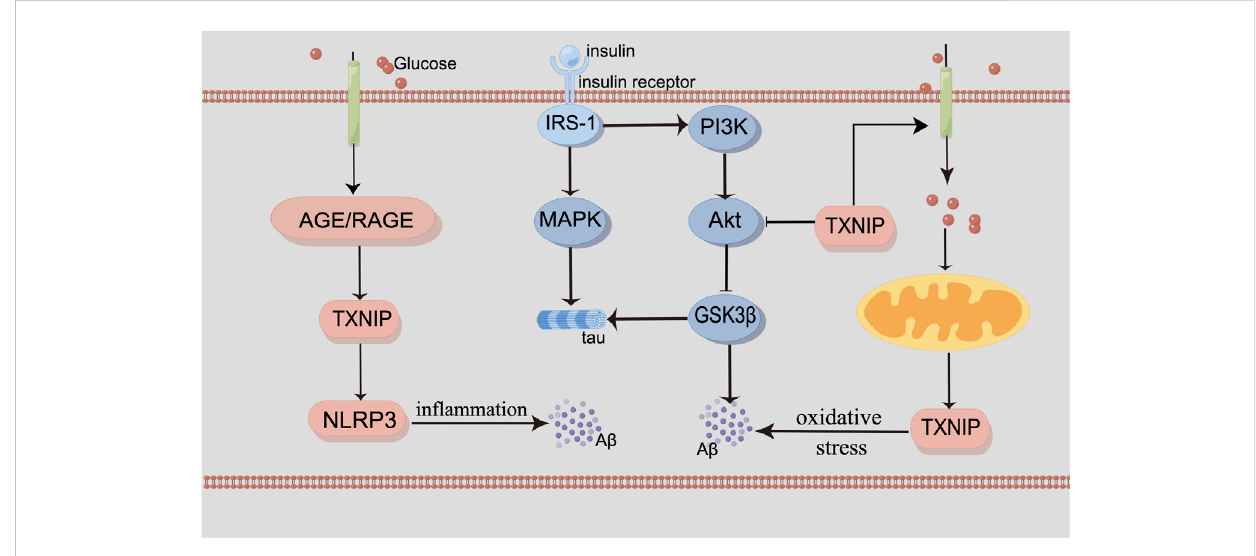
FIGURE 1 ByFigdraw.TheinteractionofglucosemetabolismandthepathogenesisofAD.Insulinbindstotheinsulinreceptor,recruitingtheIRS-1proteinsand triggering two signaling cascades, including the MAPK pathway and the PI3K/Akt/GSK3 β pathway. Inhibition of PI3K and downregulation of the phosphorylated Akt protein subsequently activate GSK3 β . TXNIP is a modulator of glucose metabolism and oxidative stress. It can also be induced by AMPK.RAGE/TXNIP/NLRP3in fl ammasomecanleadtoneuroin fl ammation.Abnormalmitochondrialfunctioncaninteractwithglucosemetabolism. MAPK signaling participates in the phosphorylation of tau. And the activation of GSK3 β can also contribute to A β production and tau phosphorylation, as well as neuroin fl ammation and oxidative